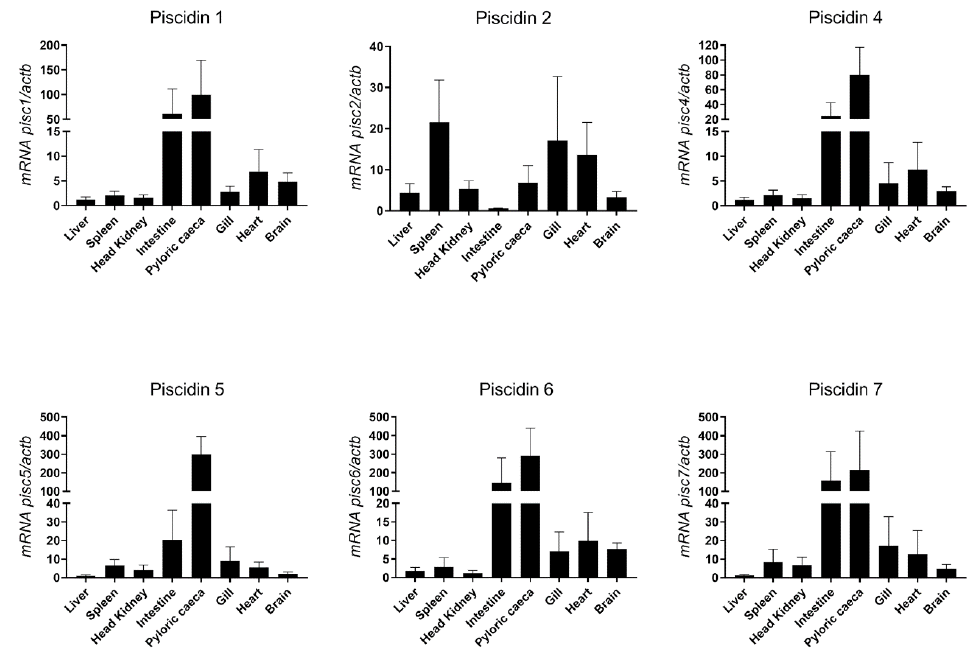
Figure 6. Basal expression of piscidin genes in different organs of healthy sea bass, measured by real-time PCR. Each sample was normalized to beta actin ( actb ) calculated by the comparative CT method (2 - ∆∆ CT ). Values are presented as means ± standard deviation (S.D.) ( n = 5).